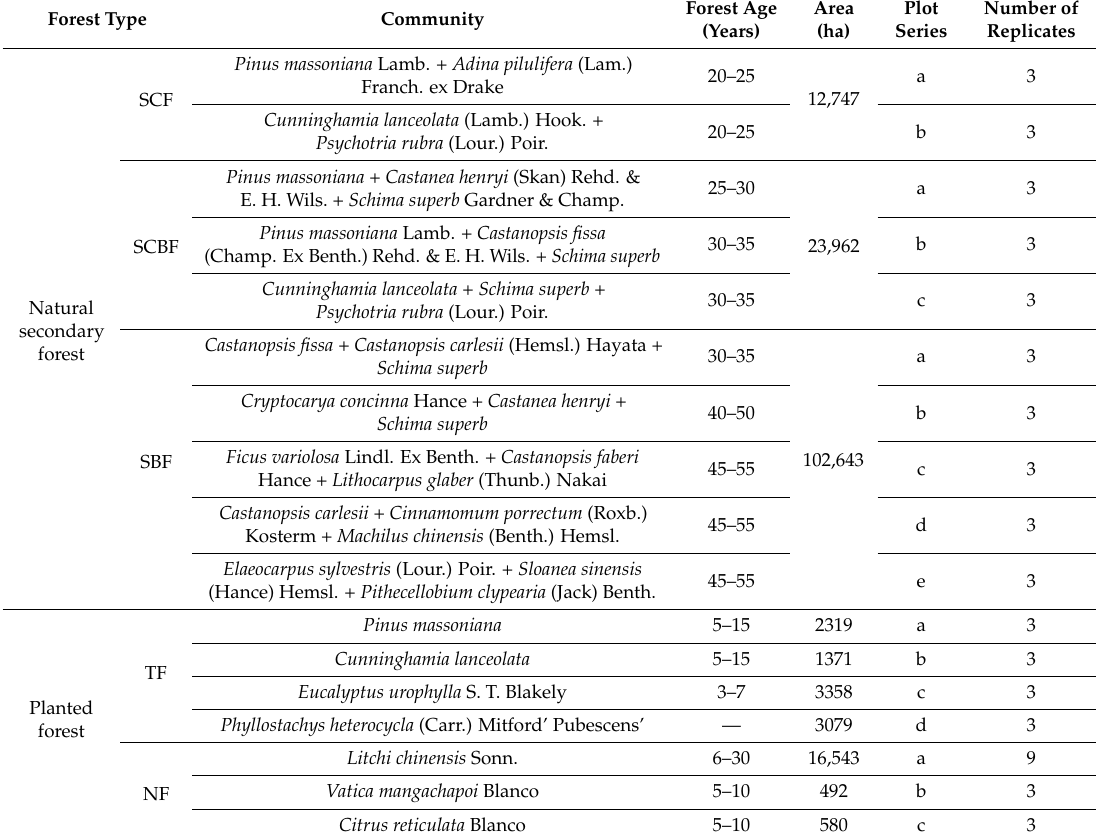
Table 1. Sampling communities of different forest